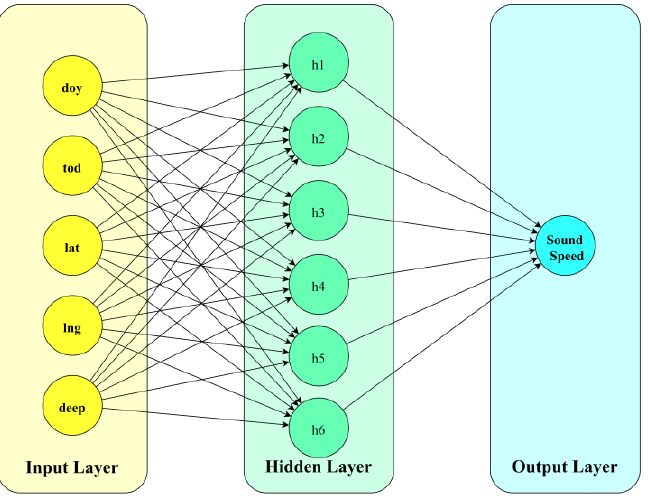
Figure 5. Three-layer BP neural network model (doy: day of year; tod: time of day).